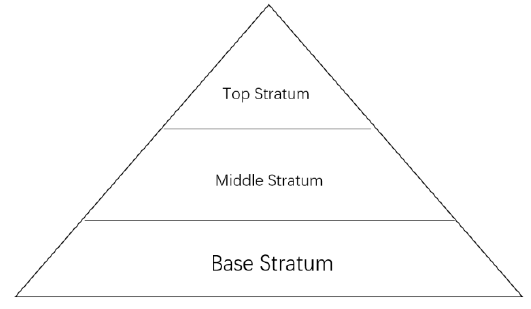
Figure 1. New Social